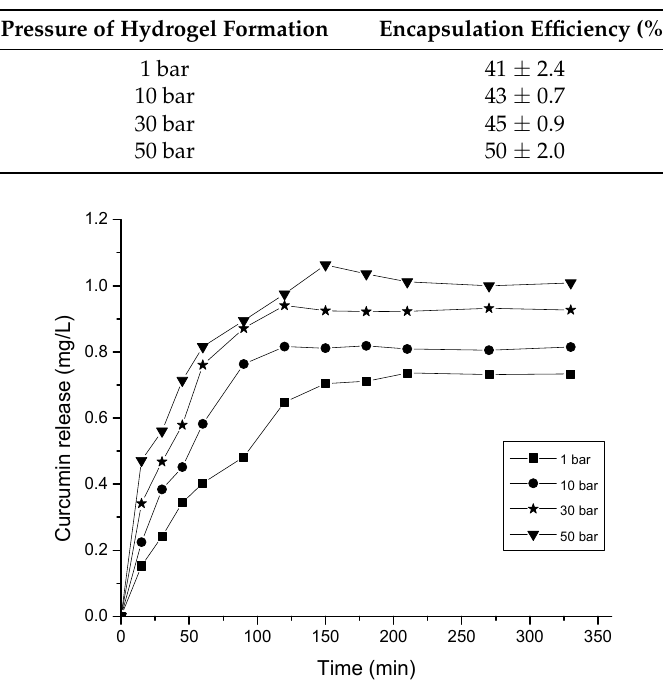
Table 3. Encapsulation efficiency of curcumin for hydrogels formed at different pressure conditions.